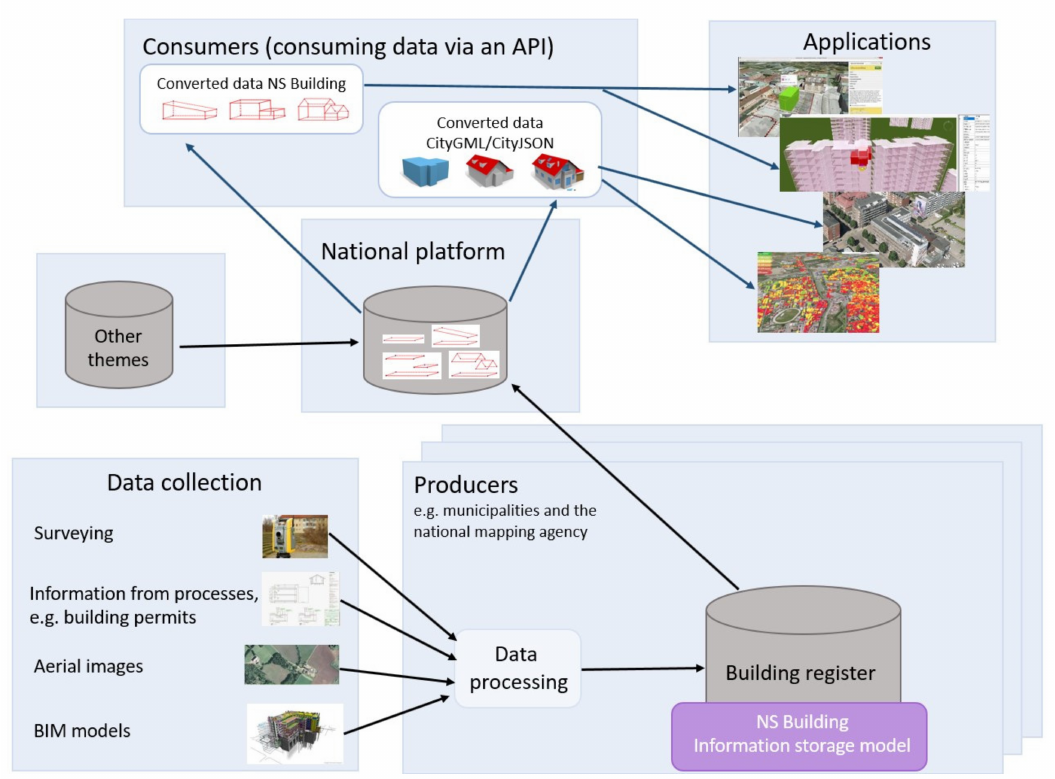
Figure 3. Proposed national solution for the exchange of building information in the planning and building